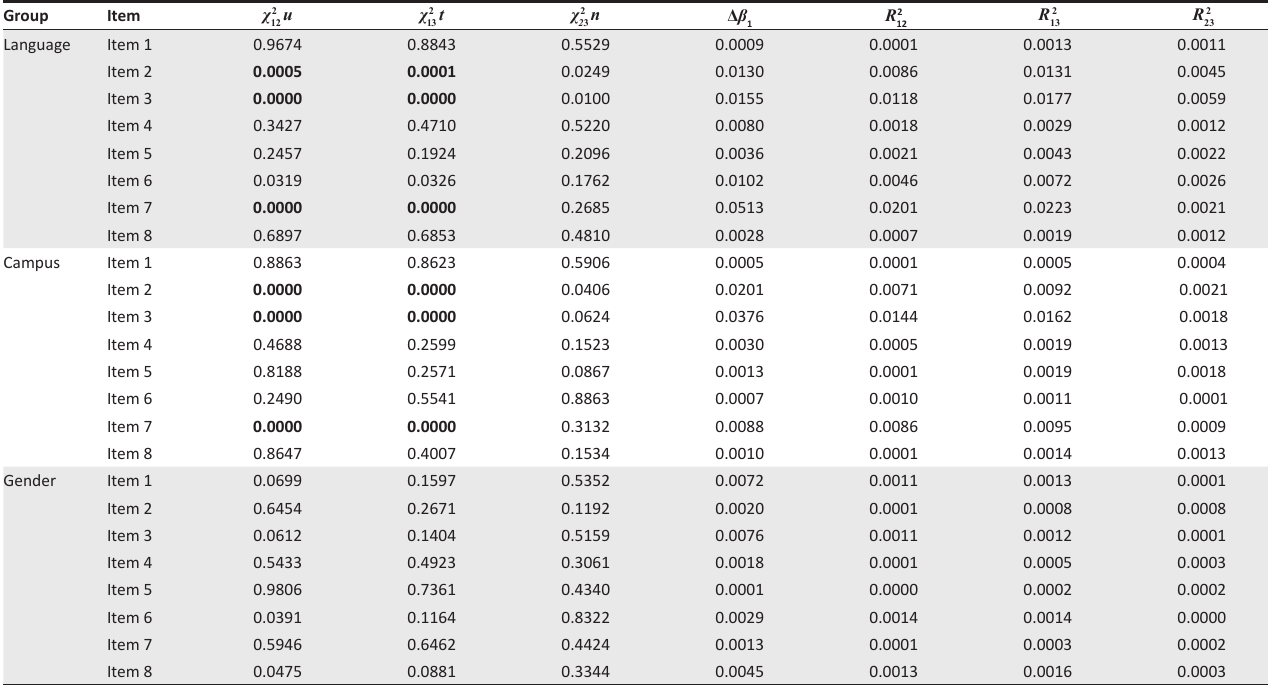
TABLE 2: Differential item functioning.